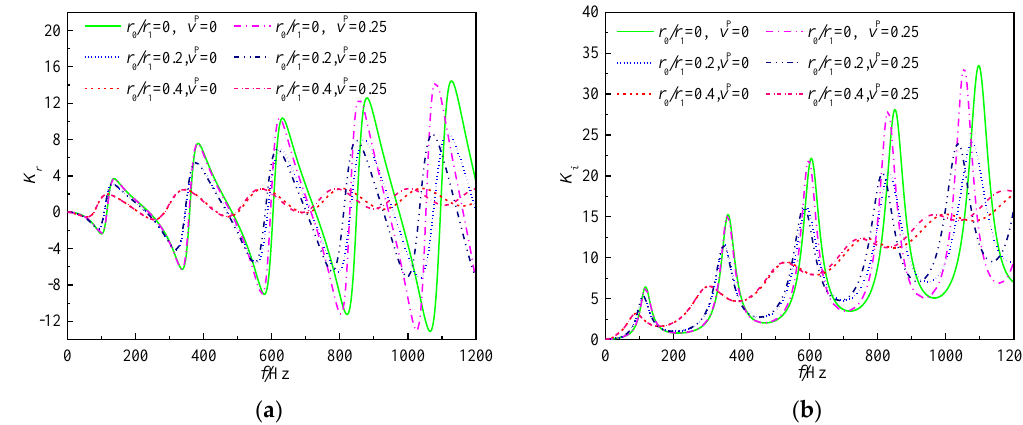
Figure 4. Variation of dynamic impedance with the diameters ratio: ( a ) true stiffness and ( b ) equivalent damping.